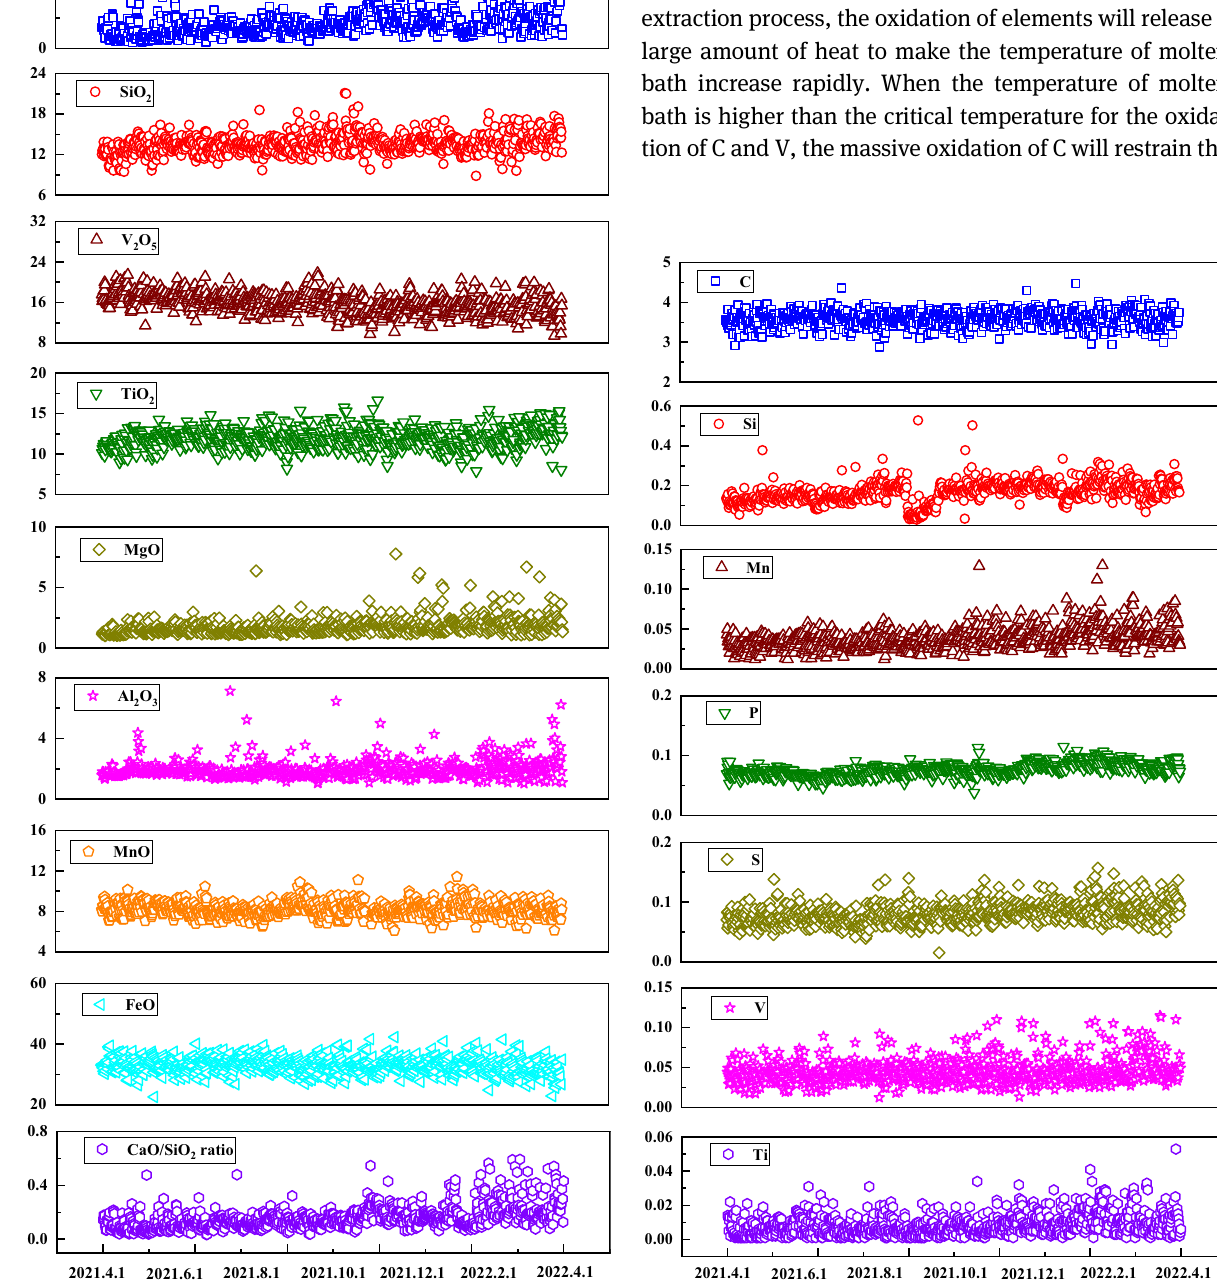
Figure 6: Composition ( wt% ) of slag produced in the V - recovering BOF over the 1 year ( 2021 – 2022 ) .